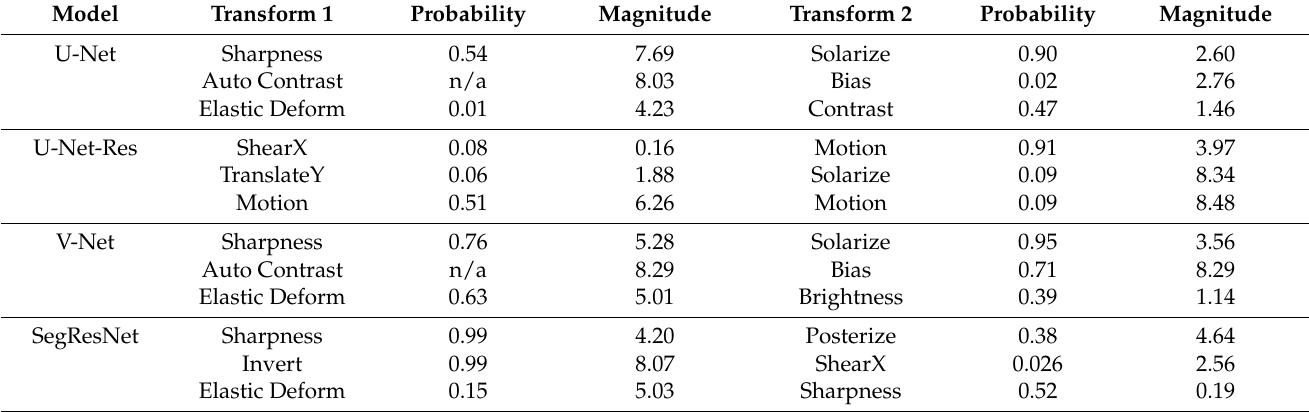
Table A1. Optimal policies selected by our Med-Aug search algorithm with the Cardiac dataset. Model